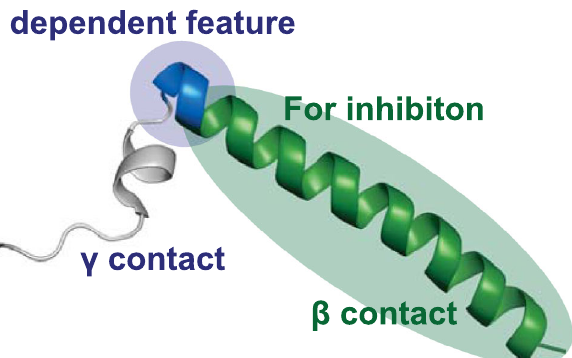
Fig.6|Theproposedmechanismspresentedinthisstudy.a Couplingschemeof IF 1 dissociationwiththerotarymechanismin b MF 1 .Apartofthereactionschemeof rotary catalysis in b MF 1 (Fig. 1a) is described with only the essential elements. The green oval represents IF 1 . The green line in the scheme represents the IF 1 binding angle in the range of – 40°-0°. The blue line represents the angular difference (0° – 200°) required for the conformationaltransition of theblue β subunit from β E to β DP via β TP . The black line represents the angle distance for IF 1 dissociation, estimated in the stall-and-release experiment. b Schematic representation of the roleofIF 1 (PDB:2v7q).TheN-terminalregionofIF 1 wrapsaroundthe γ subunit,and the long helix of IF 1 interacts with the β DP subunit. In addition to the N-terminal amino acid residues, including the short helix (residues 14-18), residues 20 – 22 (blue) play a critical role in the rotation-direction-dependent activation. Residues starting at residue 23 (green) in the central long helix work as a prototypical